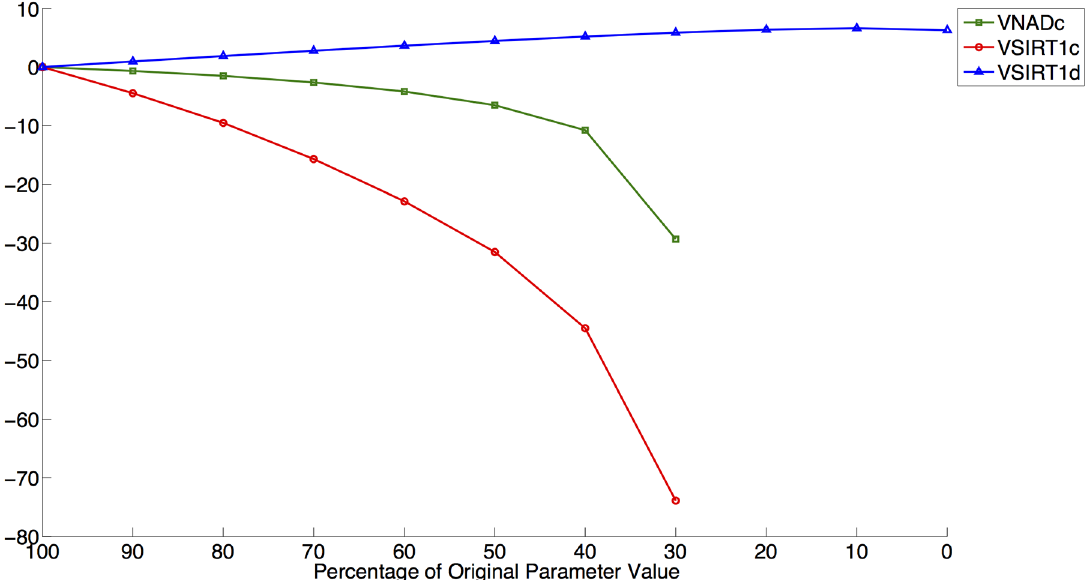
Fig 9. Percentage change in maximal levels of CRY/PER mRNA levels for SIRT1-related parameter values. Green/Square: VNADc; Red/Circle: VSIRT1c; Blue/Triangle: VSIRT1d. Data points shown for region of stable oscillation.